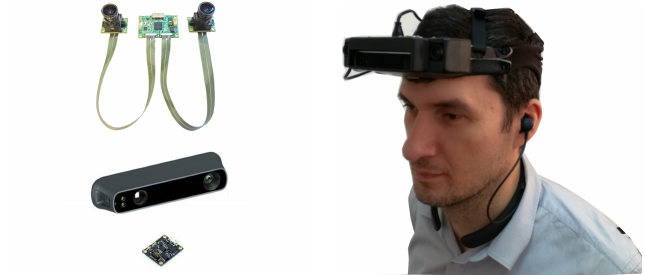
Figure 1. The Sound of Vision headgear: ( left ) 3D acquisition devices integrated in the SoV system—stereo camera (LI-OV580 from Leopard Imaging), IR depth sensor (Structure Sensor PS1080 from Occipital), IMU device (LPMS-CURS2 from Lp-Research) and a prototype implementation of the SoV headgear ( right